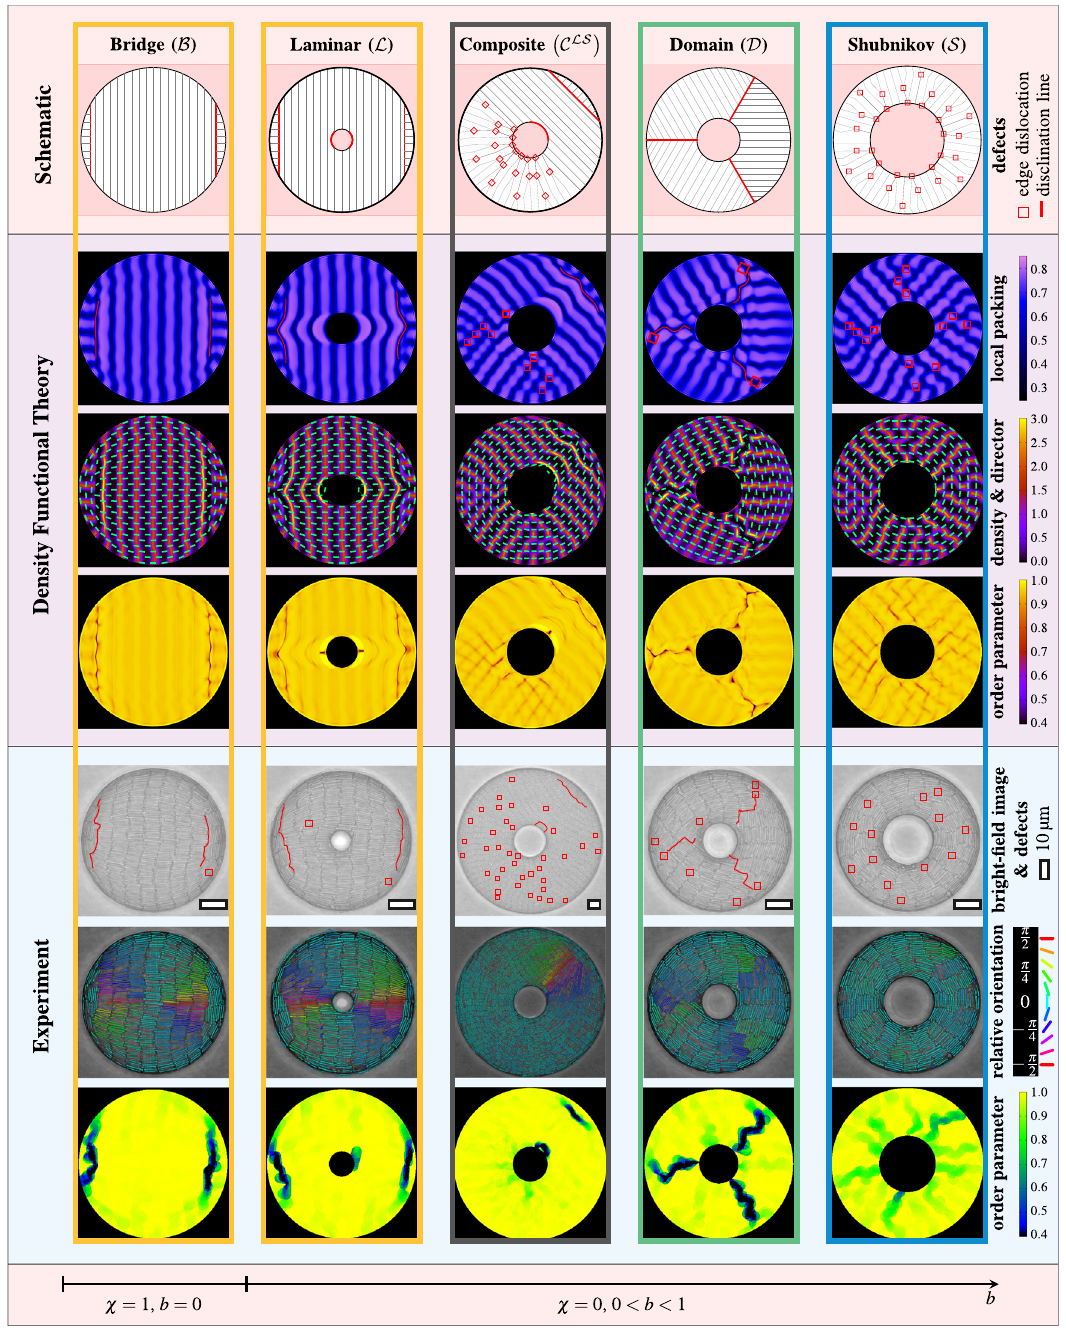
Fig. 2 Defects structures in smectic colloidal liquid crystals. The columns represent the different states (as labeled), arranged from left to right by their occurrence in circular (Euler characteristic χ = 1) and annular ( χ = 0) con fi nement with increasing inclusion size ratio b = R in / R out . First row : idealized schematic representation of the mesoscopic arrangement of smectic layers (solid gray lines) and defects (red squares and lines as labeled). Rows 2 – 4 : local packing fraction with marked defects, density pro fi les with orientational director fi eld (as in Fig. 1d) and local order parameter from theory. Rows 5 – 7 : typical particle-resolved snapshots with defects or color denoting the orientation relative to the nearest wall and local order parameter from